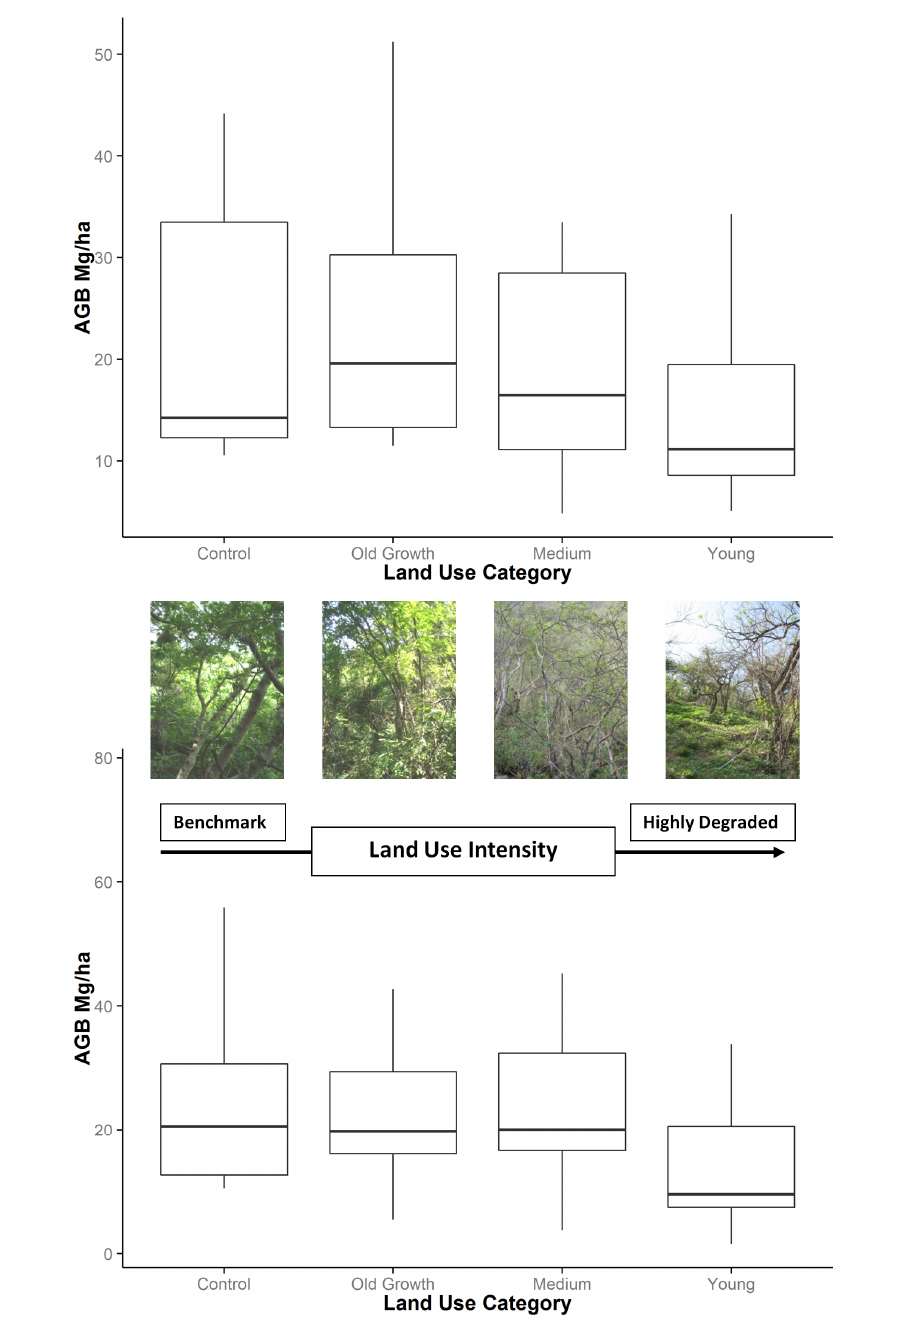
Figure 2. Aboveground biomass for tropical dry forests grouped in four land use categories according to altitude: ( a ) 1200–1700 ( n = 47); ( b ) 900–1200 ( n = 54) for the Junta Intermunicipal de la cuenca del Rio Ayuquila, Jalisco, Mexico. Land use categories are defined according to time since last clearance: Control = no clearance (Benchmark), Old Growth = more 40 years (D1), Medium = 10–20 years (D2), Young = less than 6 years (D3-highly degraded). The error bars show the maximum and minimum value for each category and the box corresponds to first and third quartile, the centreline is the median